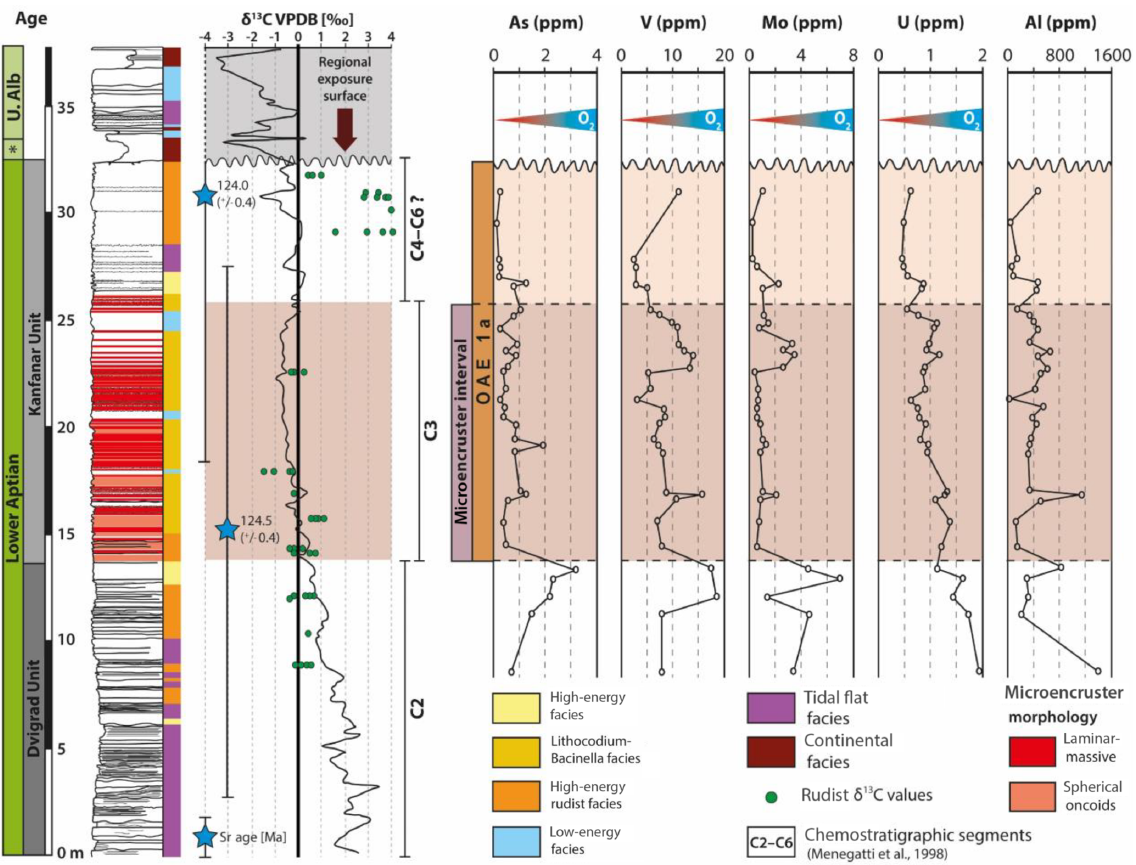
Figure 4. Chemostratigraphy of redox-sensitive trace elements and aluminum content (ppm) across the lower Aptian Dvigrad and Kanfanar units. Note the position of OAE 1a-equivalent deposits and the stratigraphic interval characterized by microencruster facies (C3). Redox- sensitive trace elements indicate an abrupt decrease in seawater dissolved oxygen level across the C2 / C3 chemostratigraphic boundary coinciding with the onset of OAE 1a and the expansion of microencruster facies on the platform